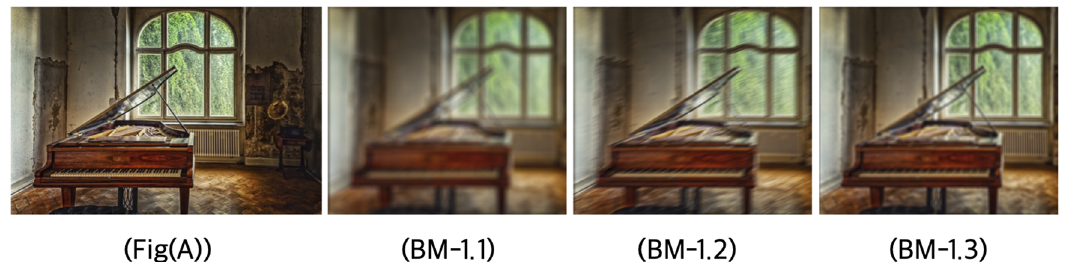
Figure 1: The original image size × 448 298 ( Fig ( A )) and the deblurred RGB images by out - of - focus blur matrices with radius 6 ( BM - 1.1 ) , Gaussian blur with standard deviation 7 of the fi lter size [ ] × 5 5 ( BM - 1.2 ) , and the deblurred images by motion blur speci fi ed with the motion length of 11 pixels and motion orientation 23 ( BM - 1.3 ) , respectively.